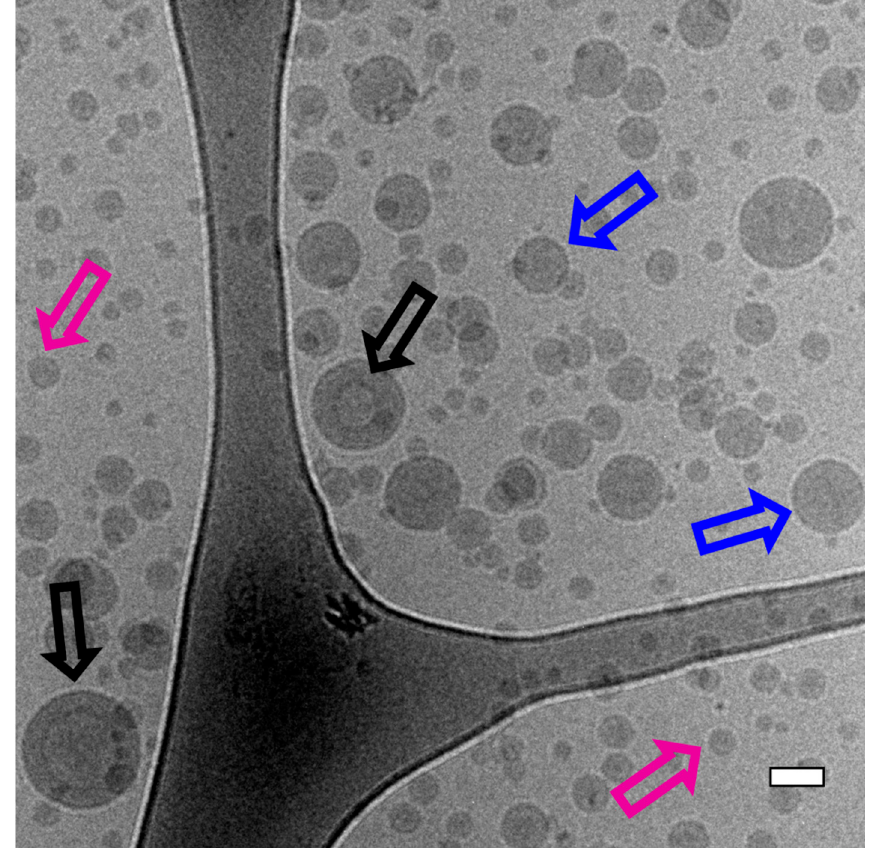
Figure 3. Cryo-TEM overview picture of block copolymer A (mPEG 5K - b -p(HPMA-Bz) 17.1K ) nanoparticles prepared at a concentration of 5 mg/mL and a flow rate of 100 µL/min. Black arrows point to vesicles such as polymersomes, blue arrows point to bigger micelles and the purple arrows point to smaller filled micelles. Scalebar indicates 50 nm.